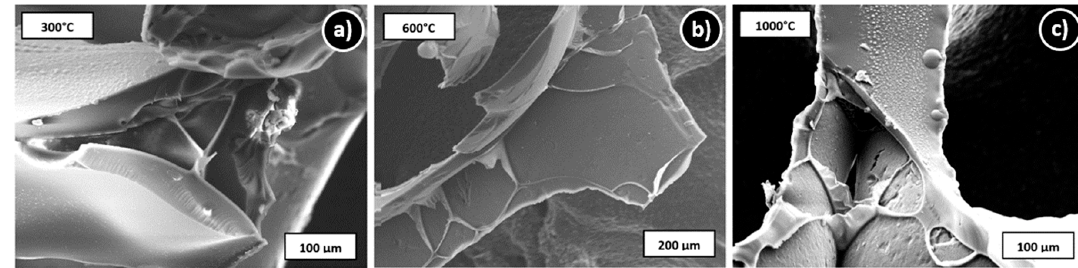
Figure 6. ( a ) Thermogravimetric analysis of the preceramic coating material without fillers (oFS), of